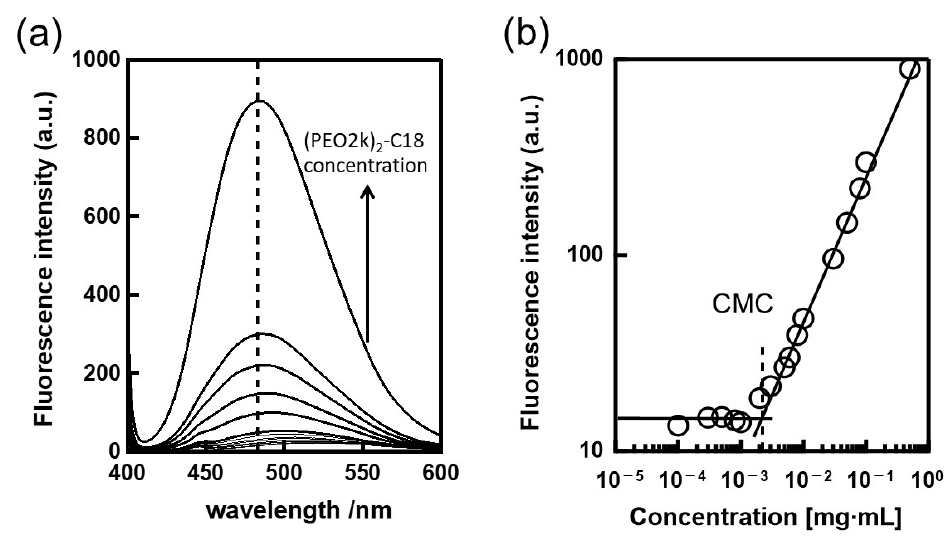
Figure 1. ( a ) Change in fluorescence spectrum of sodium 8-anilino-1-naphthalene sulfonate (ANS-Na) in aqueous (PEG2k) 2 -C18 solution with change of (PEG2k) 2 -C18 concentration. ( b ) (PEG2k) 2 -C18 concentration dependence of fluorescence intensity at 490 nm ( I 490nm ). Critical micelle concentration (CMC) is defined as the concentration at which the slope of concentration dependence of I 490nm drastically changes.